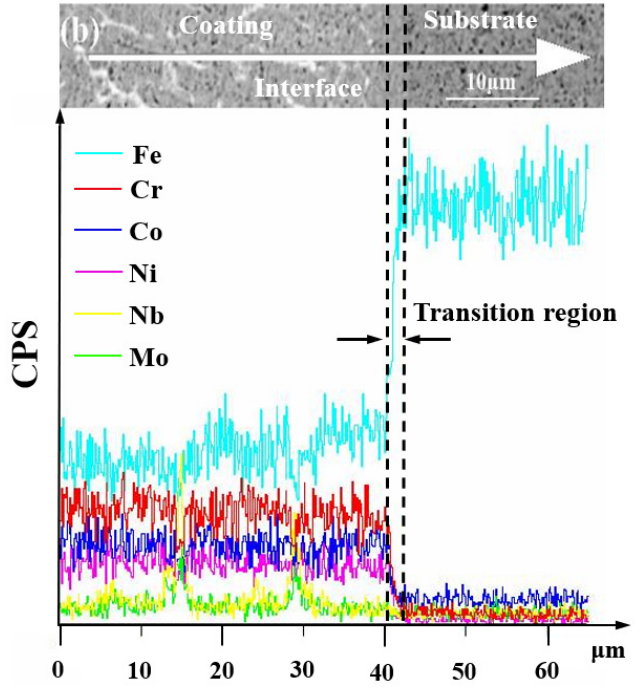
Figure 7. ( a ) SEM image of longitudinal section of the ((CoCrFeNi) 95 Nb 5 ) 99 Mo 1 coating prepared under the laser beam power of 800 W, ( b ) distributions of alloying elements by EDS line scanning.